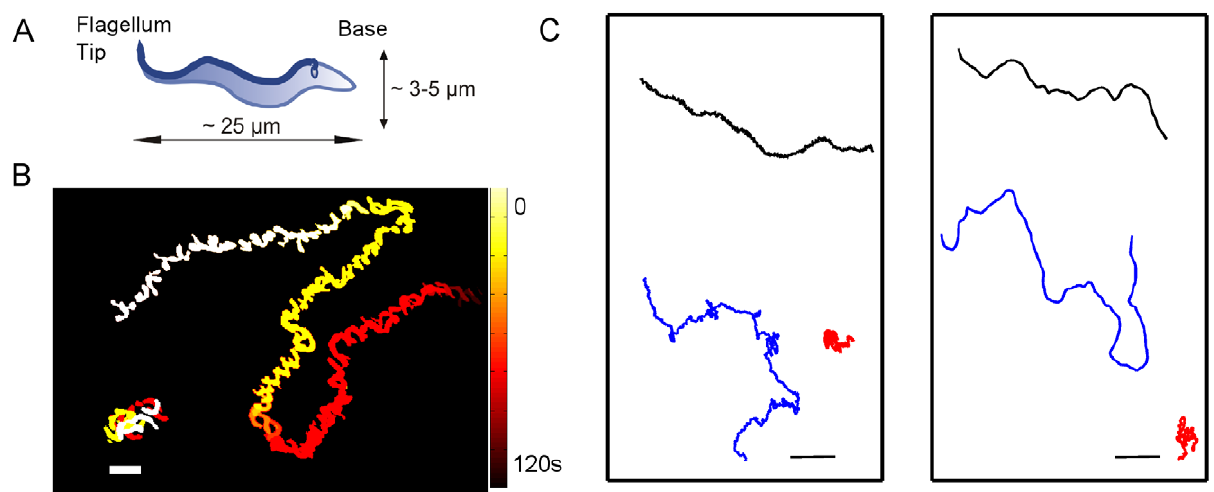
Figure 1. Trypanosome trajectories. a) Scheme of a typical trypanosome cell shape with dimensions. The flagellum originates at the flagellar pocket, near the kinetoplast and runs along the entire body b) Time-lapse overlay of trypanosomes trajectory illustrates tumbling (lower left), and running motion (upper right), scale bar 20 m m , colorbar represents time, both trajectories represent about 2 minutes of trypanosome swimming. c) Diversity in trypanosome trajectories, reveals three motility modes in which cells tumble (tumbler, in red), travel directionally (persistent, in black), or alternate between tumbling and running motion (intermediate, in blue). Left panel derived from experiment, right panel from model, scale bars 50 m m .